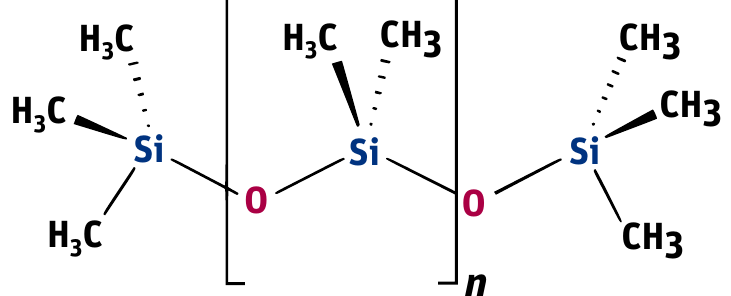
Figure 2. Formula of poly(dimethylsiloxane) containing methyl groups.